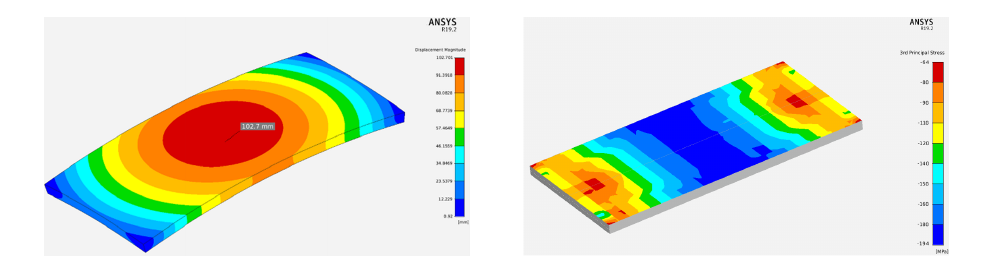
Figure 20. Deformation of the 6061 aluminium alloy plate after the quenching process.